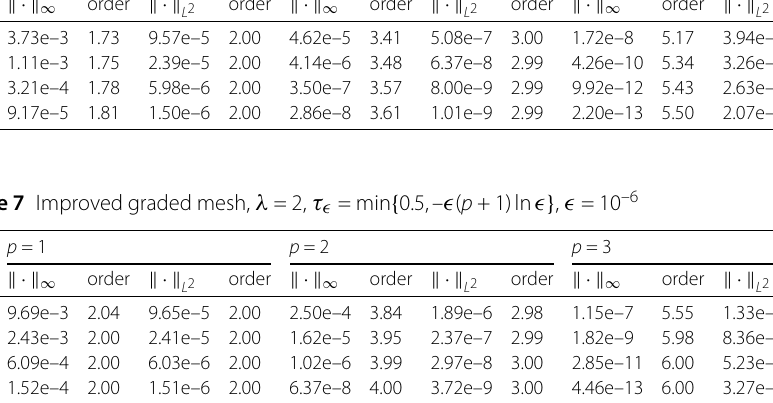
Table 6 Improved graded mesh, λ = 2, τ N = min { 0.5, (cid:2) (2 p + 1)ln( N + 1) } , (cid:2) = 10 –8 N p = 1 p = 2 p = 3 (cid:9) · (cid:9) ∞